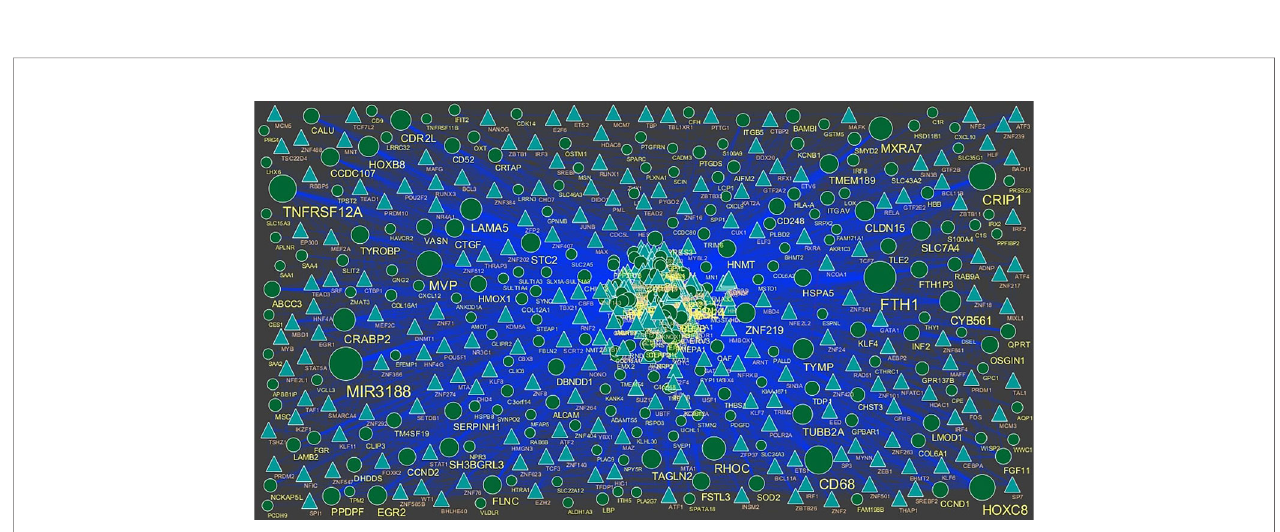
FIGURE 9 | TF ‐ gene network of predicted target up regulated genes. (Blue triangle - TFs and green circles- target up regulated